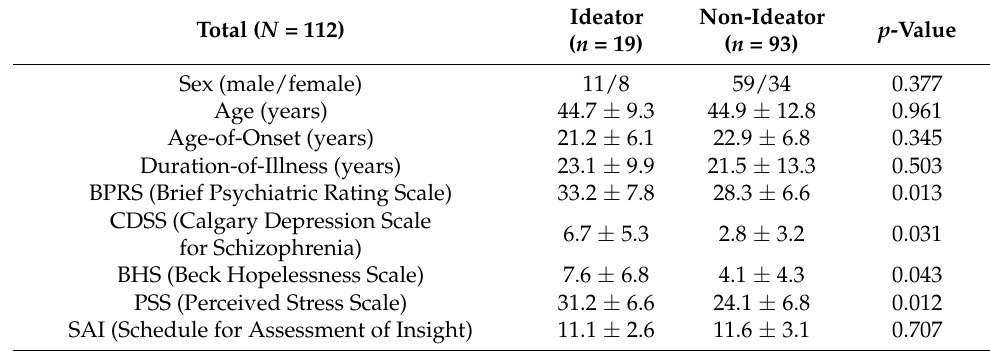
Table 1. Demographic and clinical variables in the study cohort presented as mean ± standard deviation. Variables were also tested for group differences between subjects with and without current suicidal ideation with the Mann-Whitney U test for continuous variables and the Chi-square test for categorical